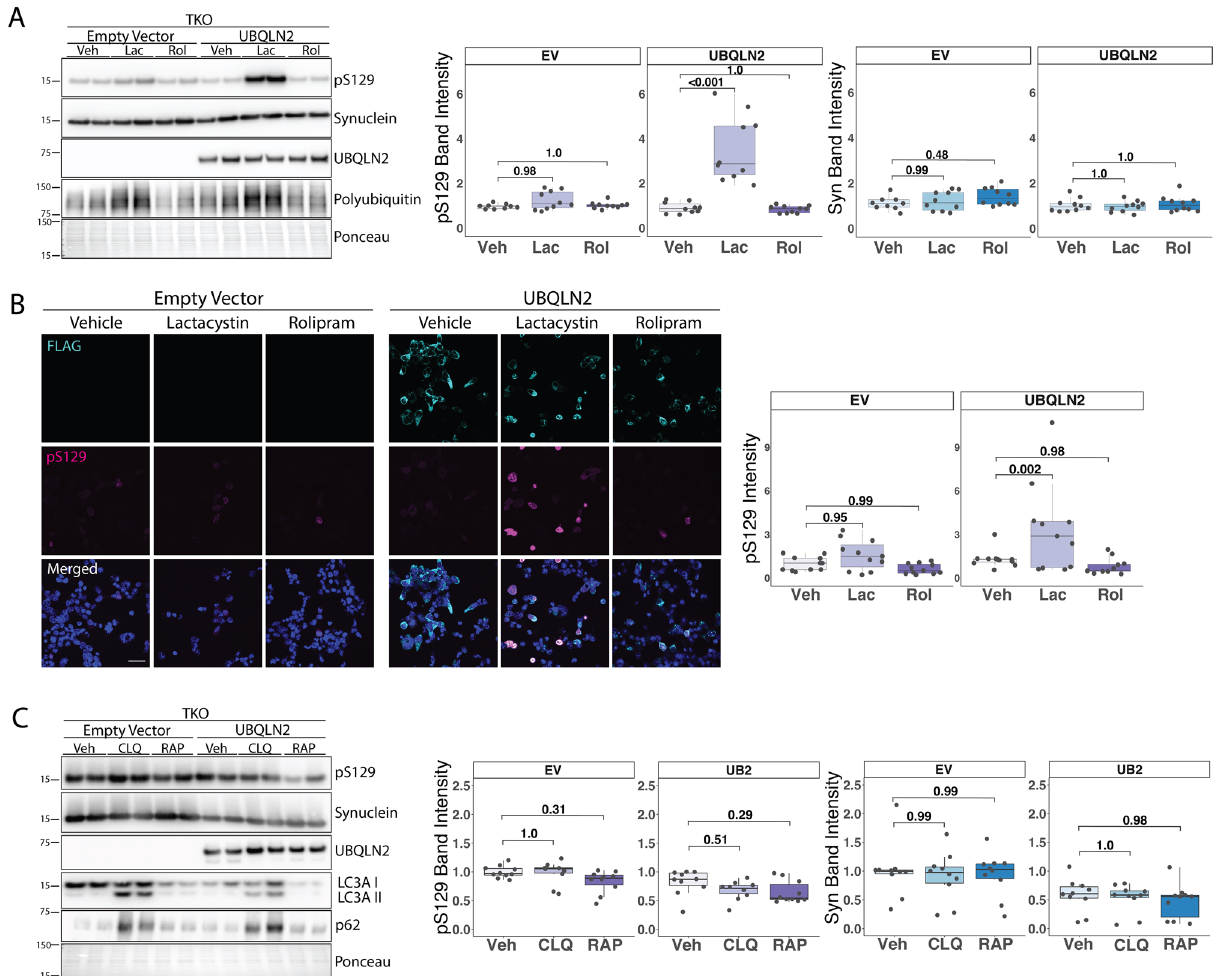
Figure 7. UBQLN2 targets pS129 α-syn to the proteasome for degradation. ( A ) Representative western blot of TKO cells overexpressing α-syn and transfected with either EV or UBQLN2 and treated with 10 μM lactacystin (Lac), 50 μM rolipram (Rol), or vehicle (Veh). Quantification of total α-syn and pS129 levels shows that pS129 accumulates in cells transfected with UBQLN2 and treated with Lac while total α-syn levels were not changed between groups (n = 9–10). Total α-syn and pS129 levels were each normalized to α-syn levels of EV, vehicle- treated cells. Western blots were cropped to focus on protein(s) of interest. ( B ) Representative images showing pS129 fluorescence in cells transfected with either EV or UBQLN2 and treated with either Veh, Lac, or Rol. Quantification of pS129 fluorescence intensity further supports that pS129 α-syn is increased when treated with Lac and in the presence of UBQLN2 (n = 11). pS129 fluorescence intensity was normalized to that of vehicle treated, EV cells. Scale bar 50 μm. ( C ) Representative western blot of TKO cells overexpressing α-syn